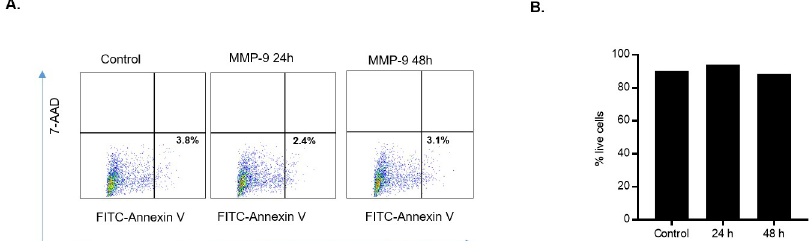
Fig 4. Effect of MMP-9 on Caco-2 cell death. (A) Dual-color dot plots representing cellular apoptosis. Upper left panel, Necrotic cells; lower right panel, apoptotic cells. Caco-2 monolayers were treated with MMP-9 for 24 and 48 hrs. Caco-2 monolayers were labeled with Annexin V FITC (apoptosis) or 7-AAD (necrosis). MMP-9 did not induce apoptosis or cell necrosis in Caco-2 monolayers. (B) % of live cell detection by trypan blue exclusion method. MMP-9 treatment did not affect total number of dead Caco-2 cells compared to